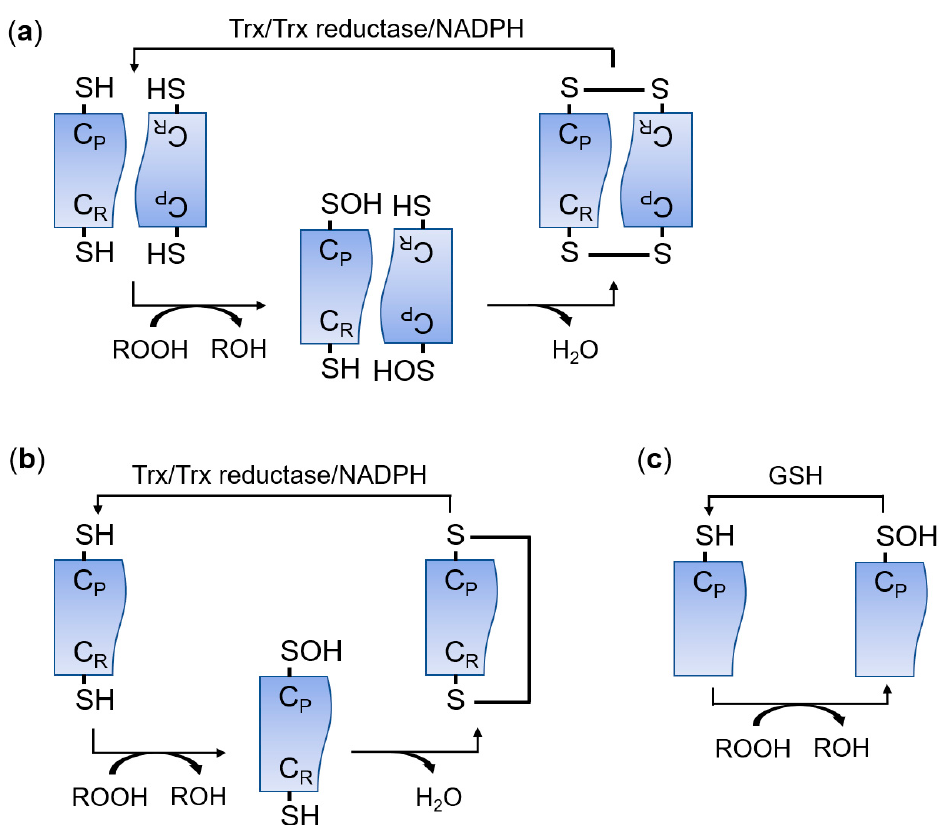
Figure 1. Catalytic cycle of typical 2-Cys ( a ), atypical 2-Cys ( b ), and 1-Cys ( c ) peroxiredoxins (PRDXs). C P , peroxidatic cysteine; C R , resolving cysteine; GSH, glutathione; ROOH, peroxide; Trx, thioredoxin.